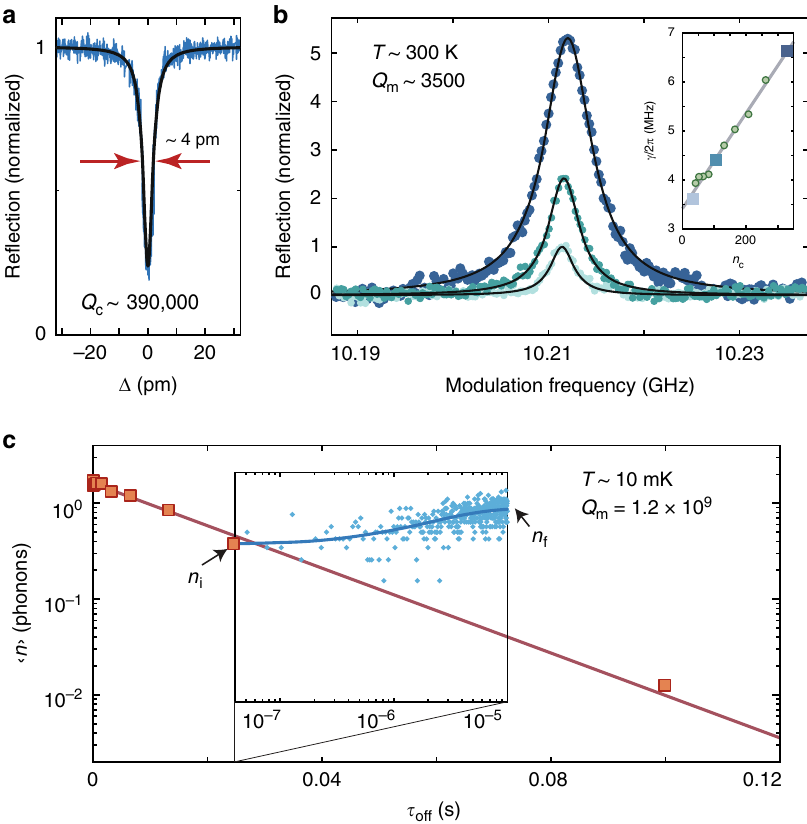
Fig. 3 Optomechanical characterization. a Optical spectrum of a quasi-2D snow fl ake OMC cavity measured using a swept laser scan. b Pump – probe measurement of the mechanical mode spectrum of interest centered around ω m /2 π = 10.21 GHz for different optical pump powers (from lowest to highest peak re fl ection: n c = 33, n c = 104, and n c = 330). Inset: measured mechanical mode linewidth versus n c . The device measured in a , b is a cavity with